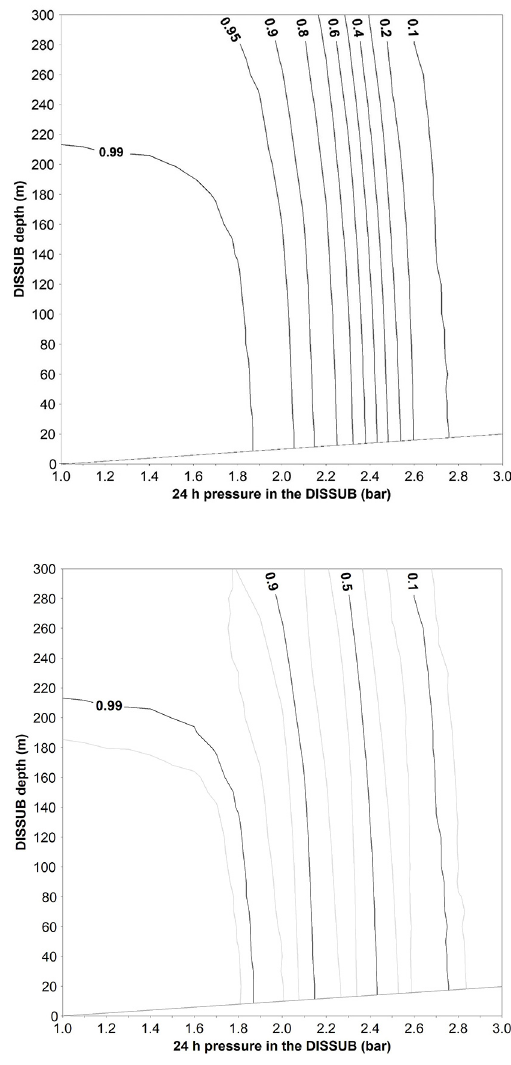
Figure 2. For future risk estimation exercises, where consensus opinion is sought, it would be more useful either to obtain estimates of an agreed range of possible values for a given parameter or to collect individual or sets of estimates and use the (geometric) mean.